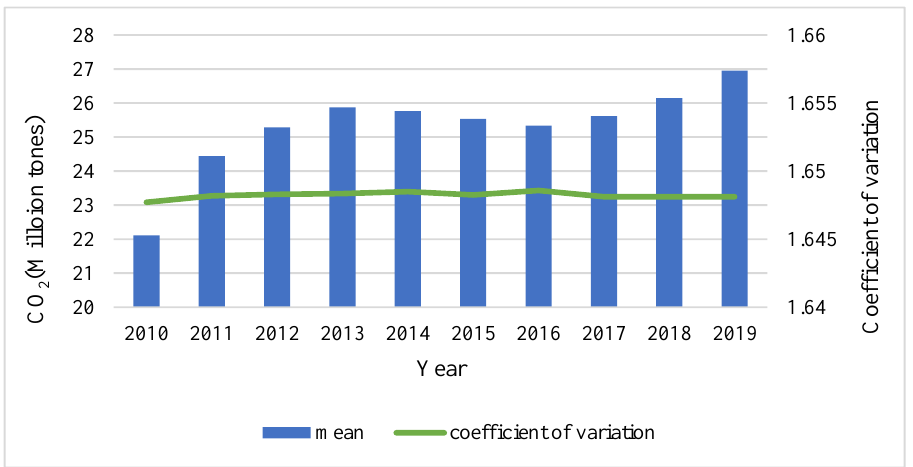
Figure 1. CO 2 emissions mean and coefficient of variation in the Yangtze River from 2010 to 2019.